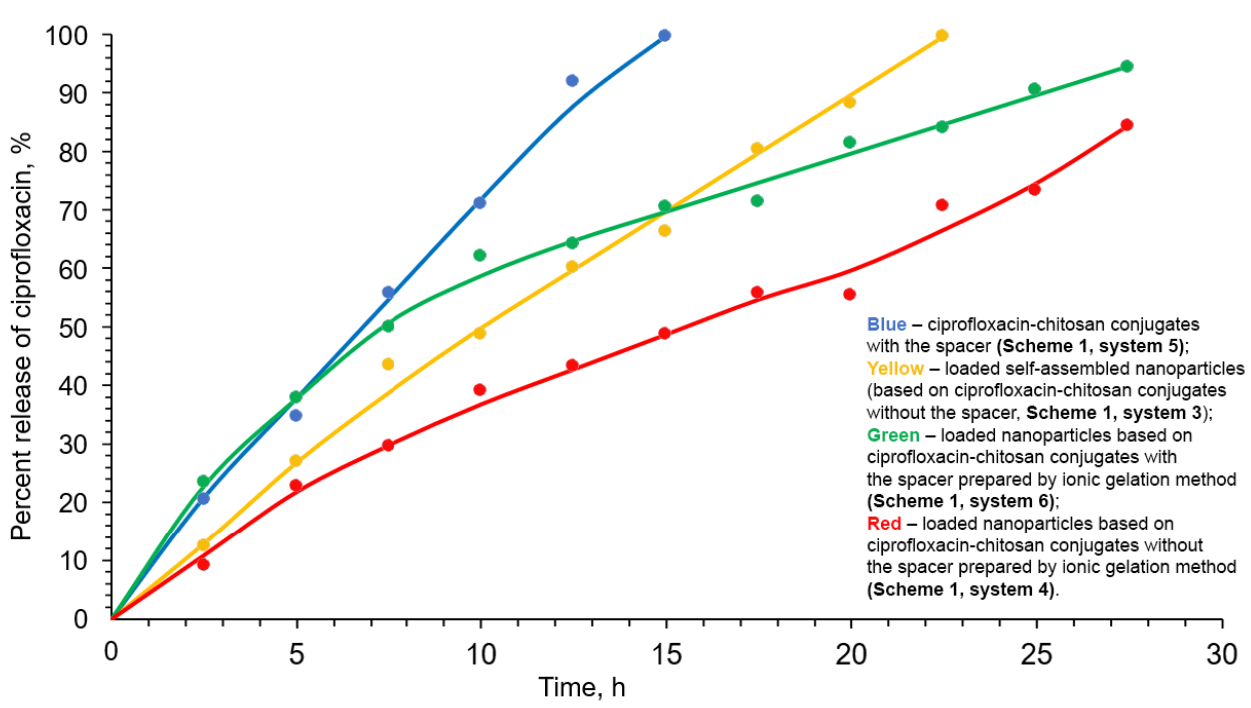
Figure 7. Ciprofloxacin release profiles from systems based on chitosan of moderate molecular weight (6.9 × 10 4 ( M ), see Section 2.1).